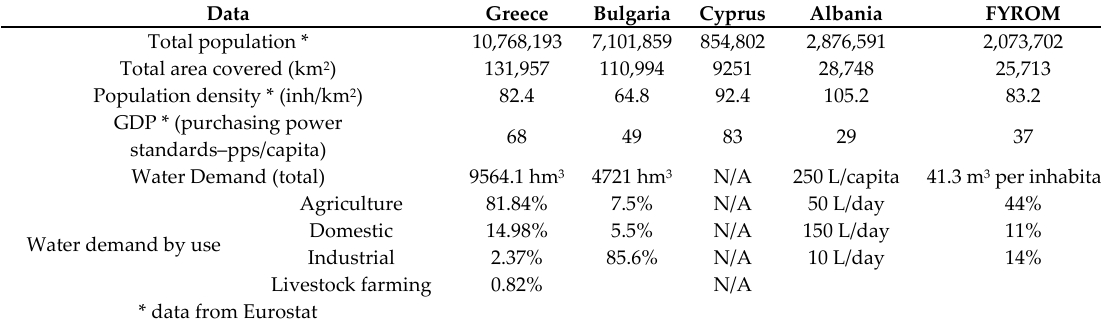
Table 1. Data of the countries involved in WATenERgy CYCLE